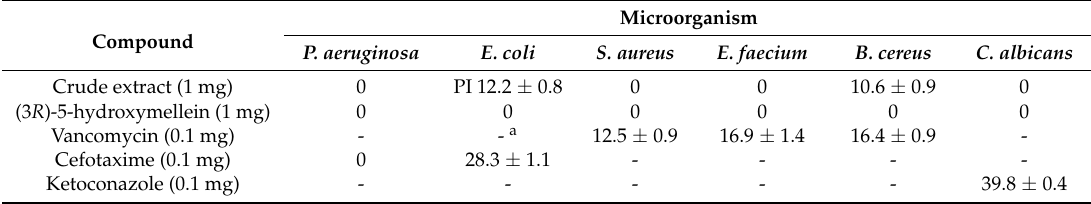
a not tested; data are the means ± SD ( n = 3).